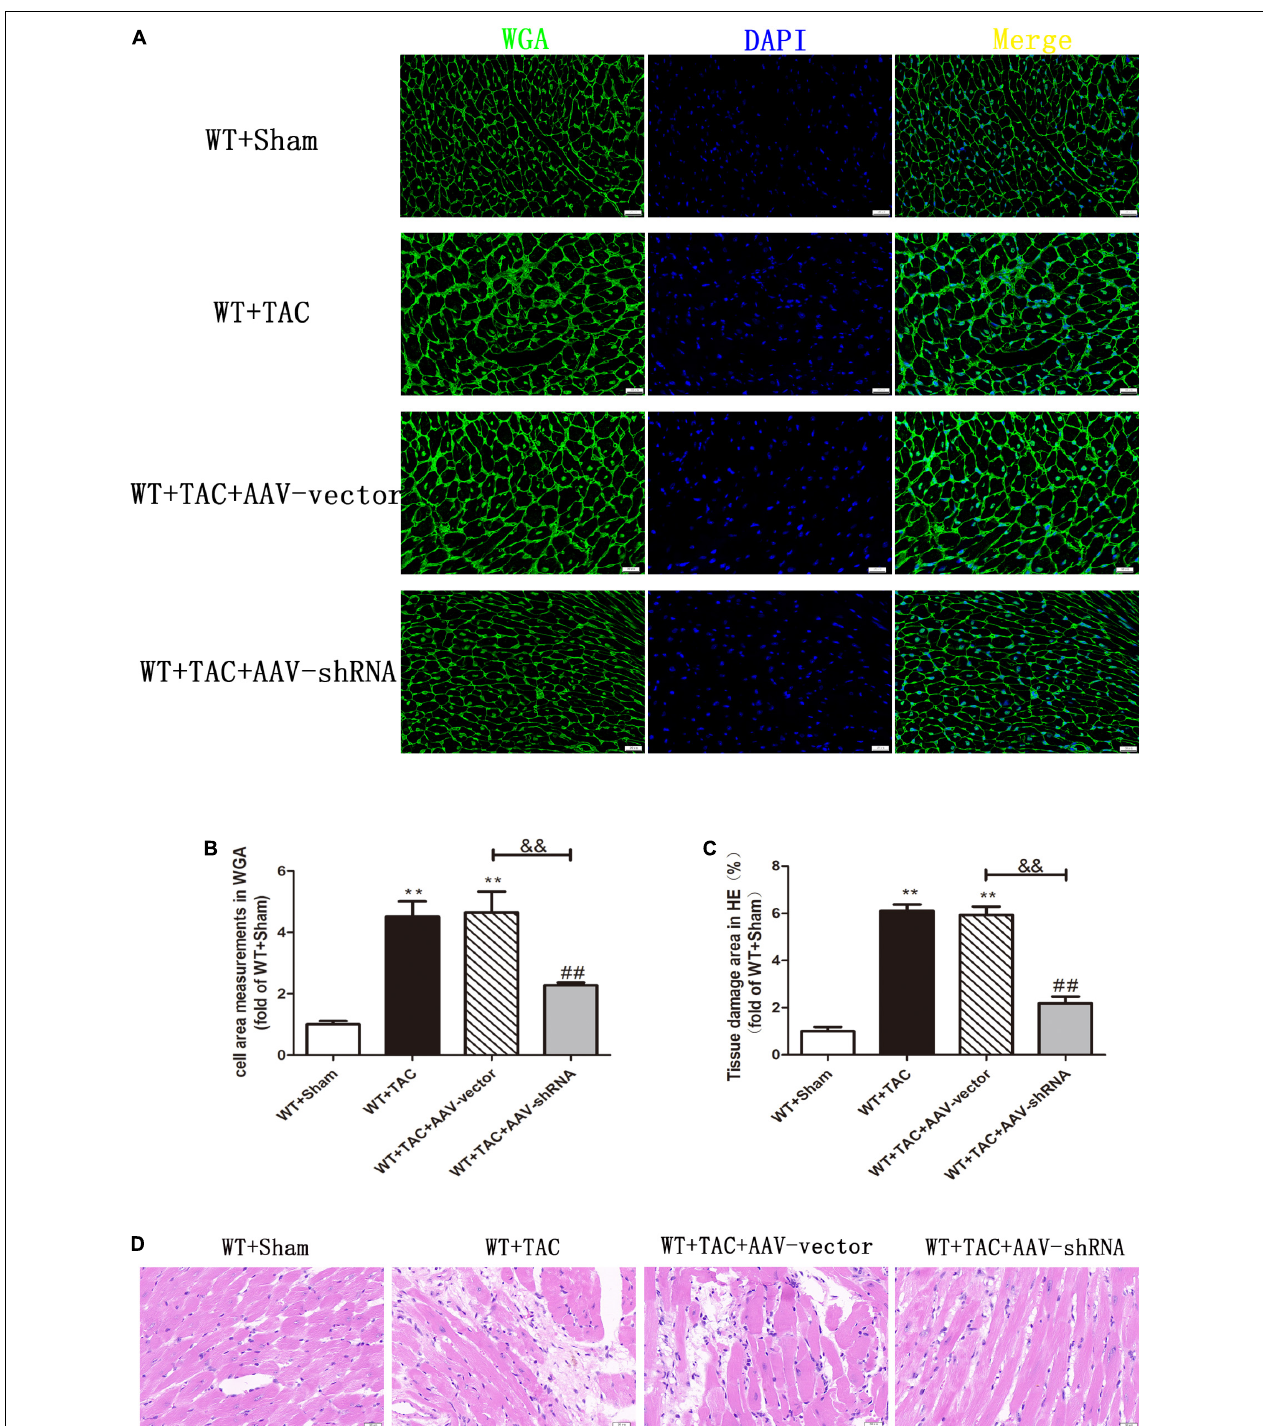
FIGURE 10 | Interference with RIPK3 can inhibit the increase of cardiomyocyte cross-sectional area in HF mice and alleviate myocardial injury. Male 8-week-old WT mice were pretreated with AAV-vector and AAV-shRNA through the tail vein, and TAC was performed using a 28-g needle. The control group received sham surgery. All groups of mice were given continuous feeding for 6 weeks. Hearts were then obtained for correlative testing. (A) The cross-sectional area of mouse cardiomyocytes was observed by WGA staining, bar = 50 µ m. (B) Cell area measurements in WGA staining. (C) Tissue damage area measurements in H&E staining. (D) H&E staining was used to detect the degree of myocardial injury, bar = 50 µ m. Compared with WT + sham group, ** P < 0.01; compared with WT + TAC group, ## P < 0.01; compared with WT + AAV-vector group, && P < 0.01. n = 6.